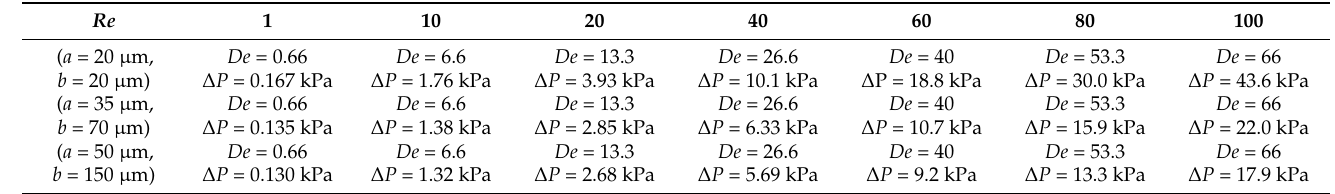
Figure 6. Reynolds number dependence of the mixing index of mixers with: ( left ) a = 20 μm and b = 1 × a ; ( middle ) a = 35 μm and b = 2 × a ; and ( right ) a = 50 μm and b = 3 × a . Table 2. Dean numbers, De , and pressure differentials, ∆ P , for mixers with various ( a,b ) geometrical parameters across the Reynolds numbers